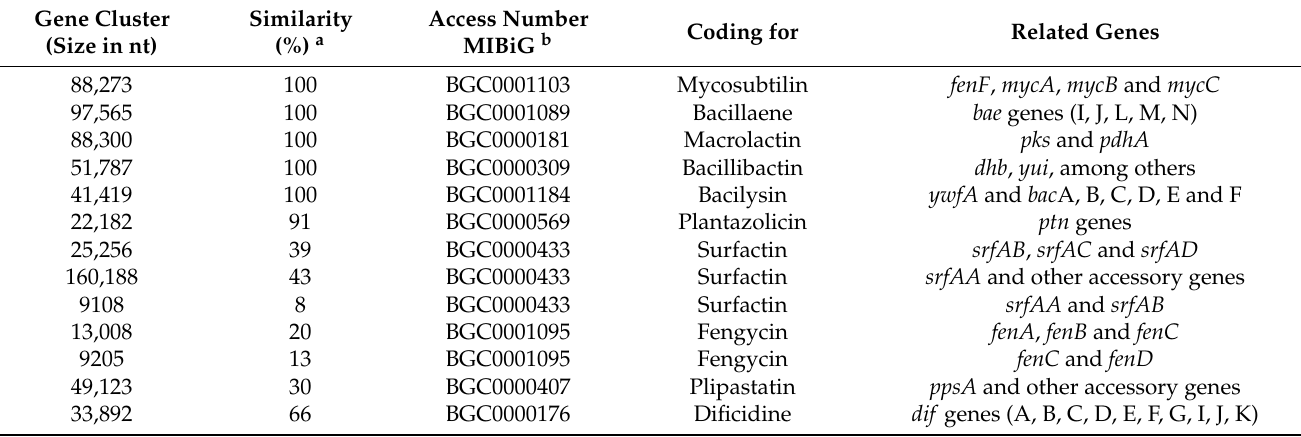
Table 1. Biosynthetic gene clusters related to the production of a variety of antimicrobial substances in the Bacillus velezensis T149-19 genome.